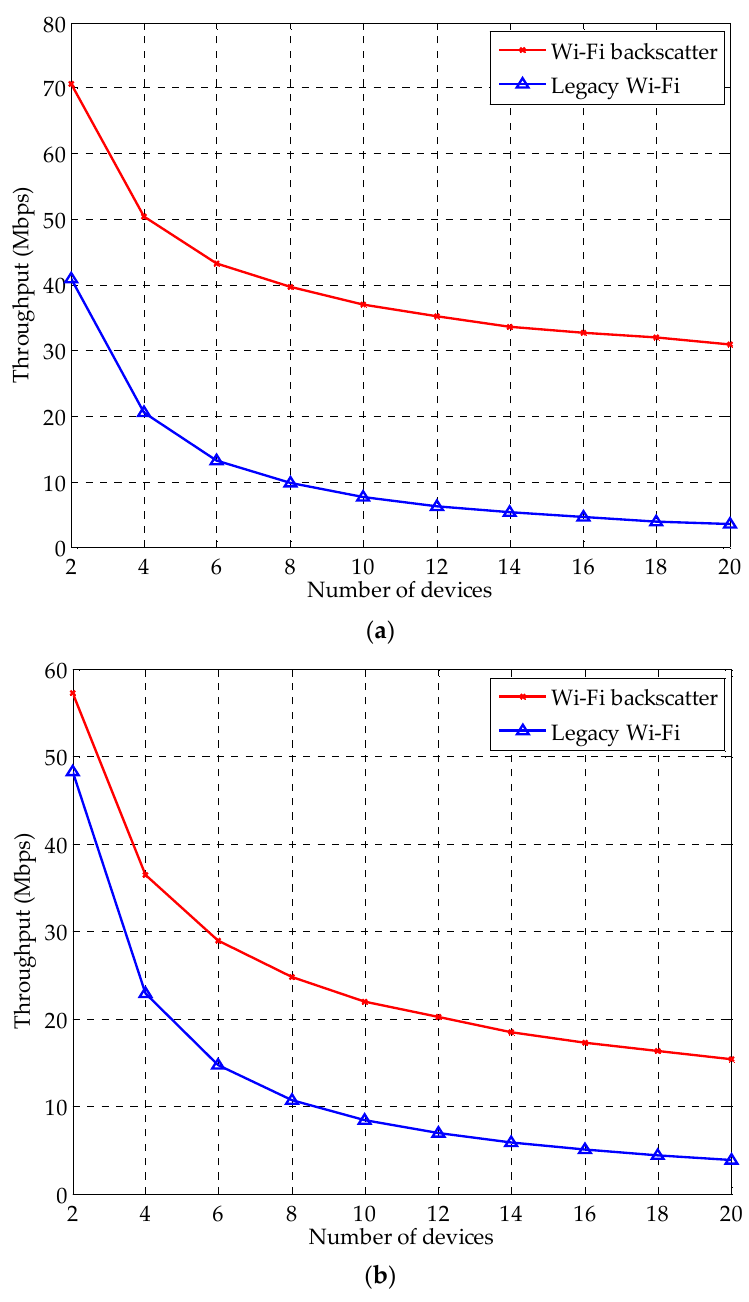
Figure 5. Variation of throughput for separate cases: ( a ) CSMA/CA starting with SIFS; and ( b ) Freezing of backoff period.